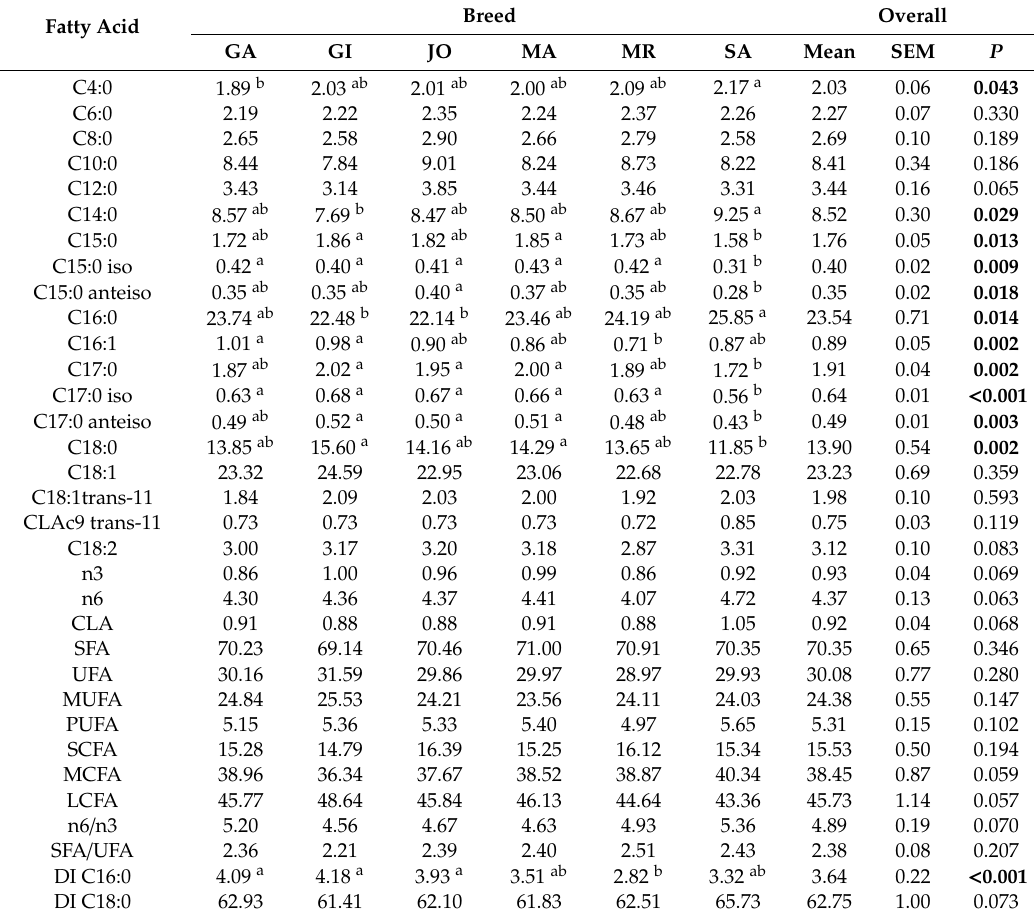
Table 3. Least squares means of individual, groups, and indices of milk fatty acid profile (g / 100 g of total identified fatty acids) of 6 goat breeds 1